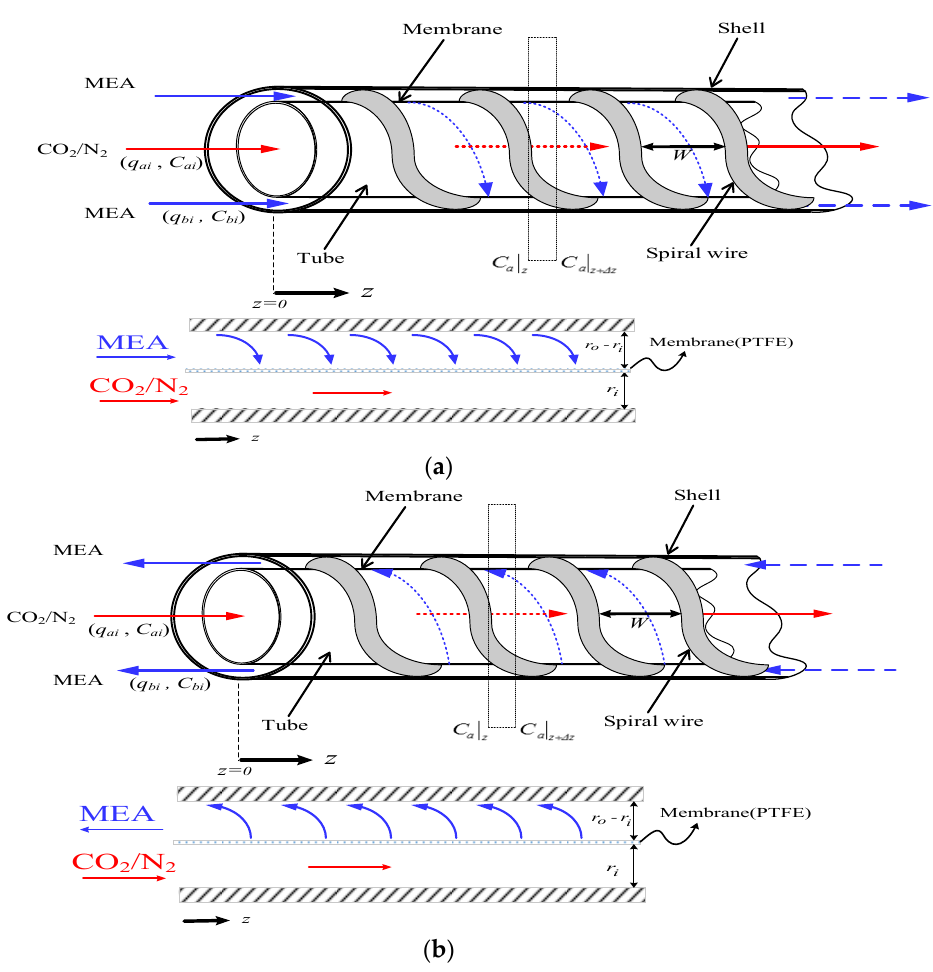
Figure 2. Spiral wired concentric circular membrane contactors. ( a ) Concurrent-flow operations; ( b ) Countercurrent-flow operations.